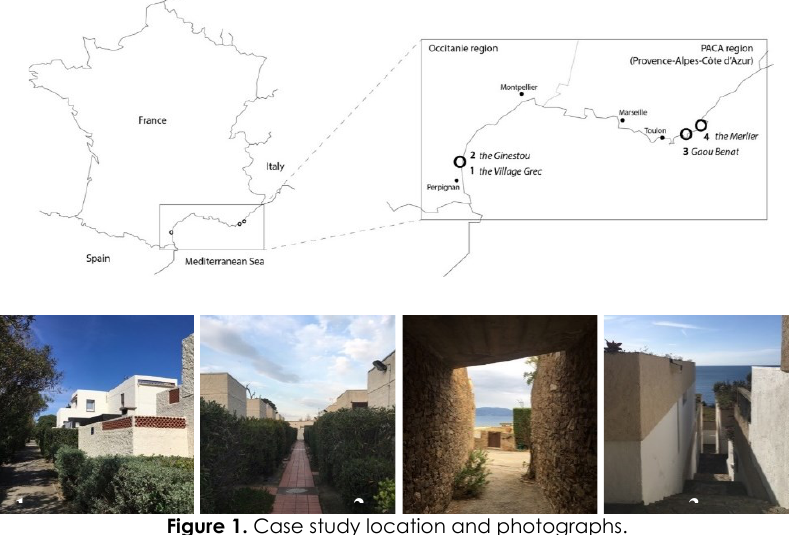
Figure 1. Case study location and photographs. (1): Village Grec in Leucate; (2): Ginestou in